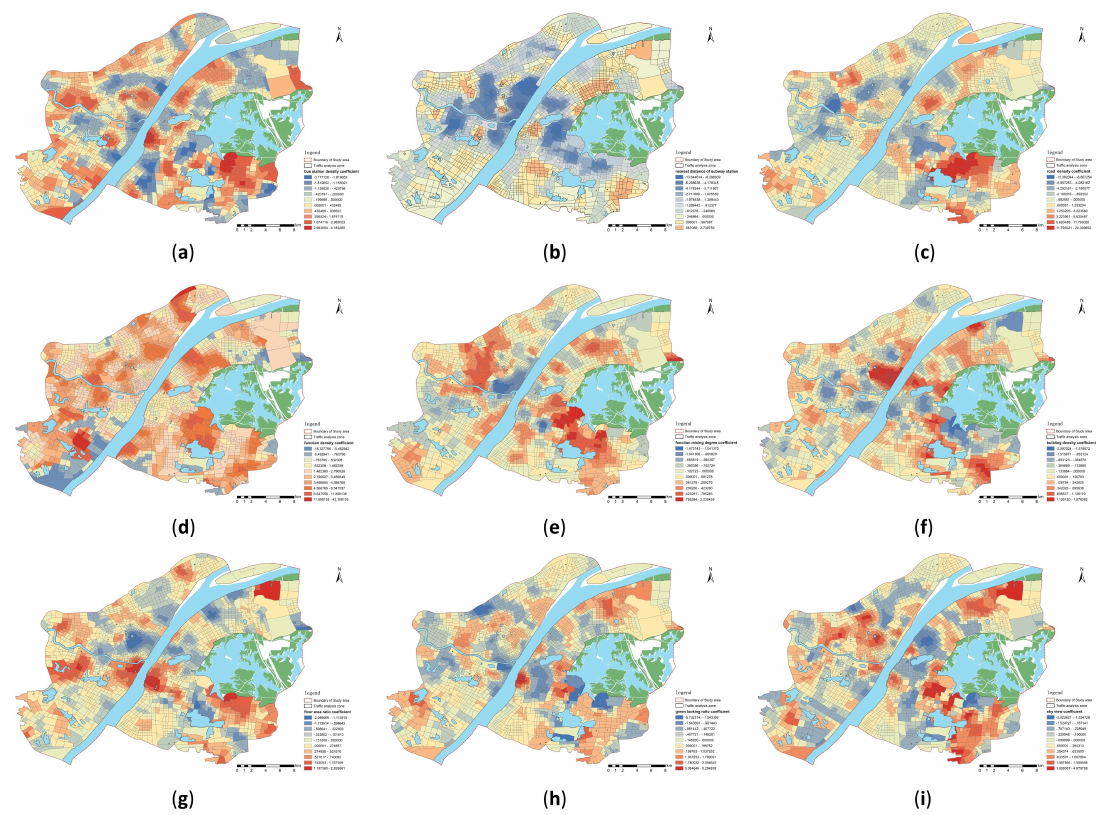
Figure 20. Distribution of regression coefficients of each indicator. ( a – i ) represent the influence coefficients of each